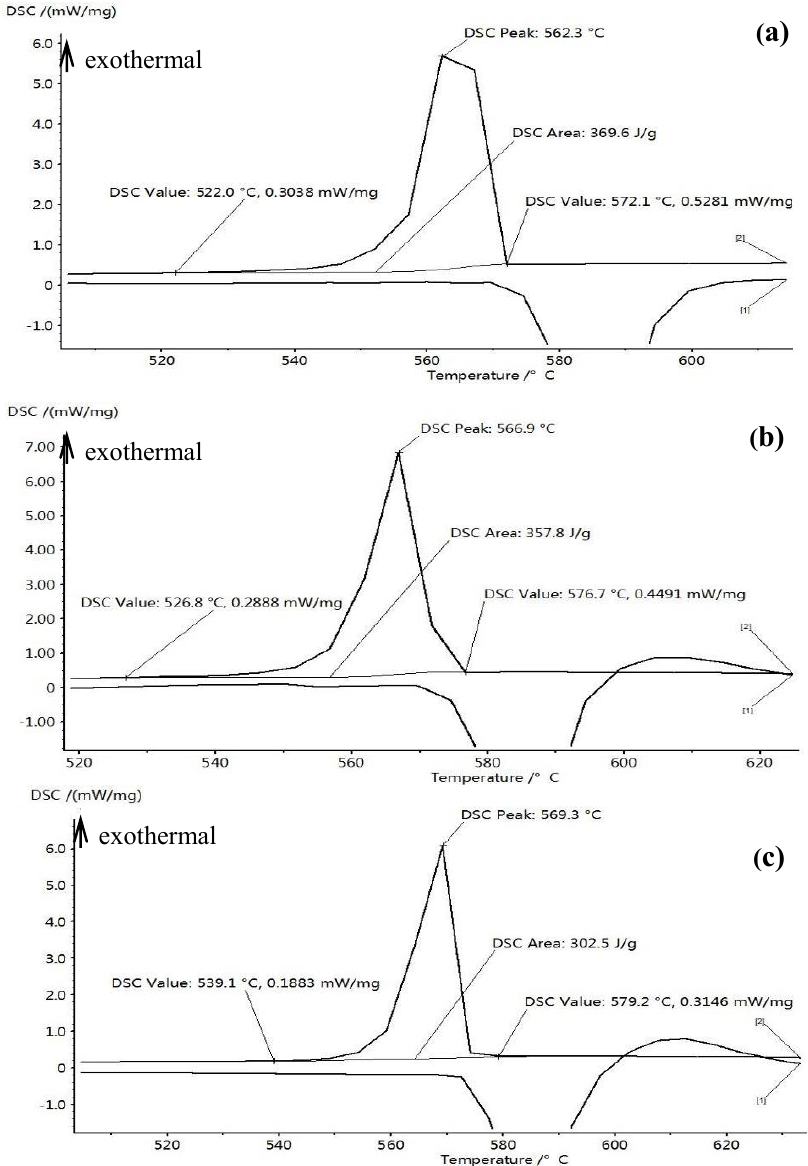
Figure 15. Part of the cooling process DSC curves between 600–500 °C: ( a ) unmodified alloys; ( b ) 10% FSM master alloy addition prepared by water-cooled copper mold; ( c ) 10%